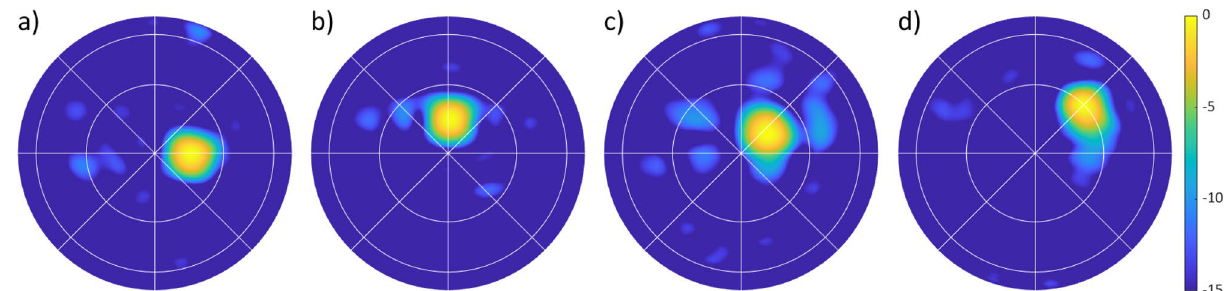
Figure 6. Each plot shows the normalized directivity (dB) radiation pattern from the Nyquist metasurface antenna. ( a ) is steered in azimuth to 15 ◦ ; ( b ) is steered in elevation to 15 ◦ . ( c , d ) show steering in both azimuth and elevation to ( 10 ◦ , 10 ◦ ) and ( 30 ◦ , 30 ◦ ),